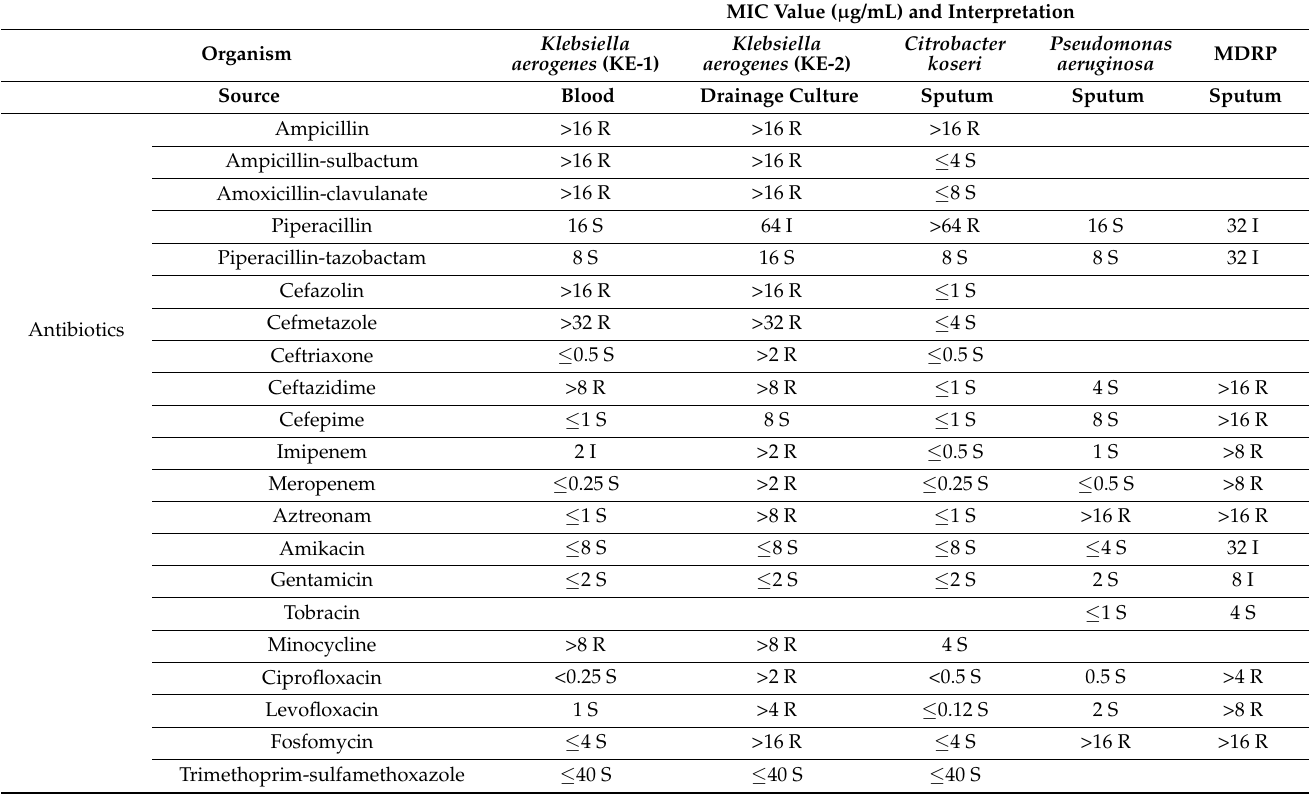
Table 1. Antimicrobial susceptibility testing in detected bacterial isolates in the present case.